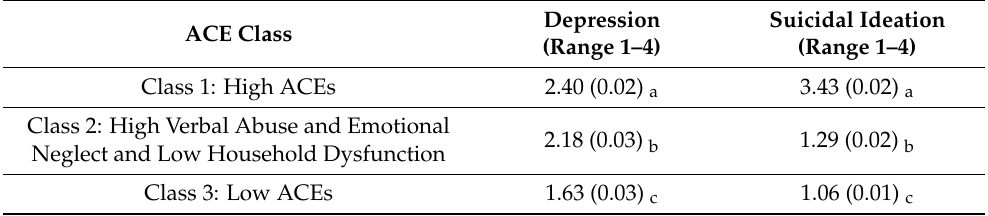
Table 4. Means and Mean Comparison of Depression and Suicidal Ideation in Each